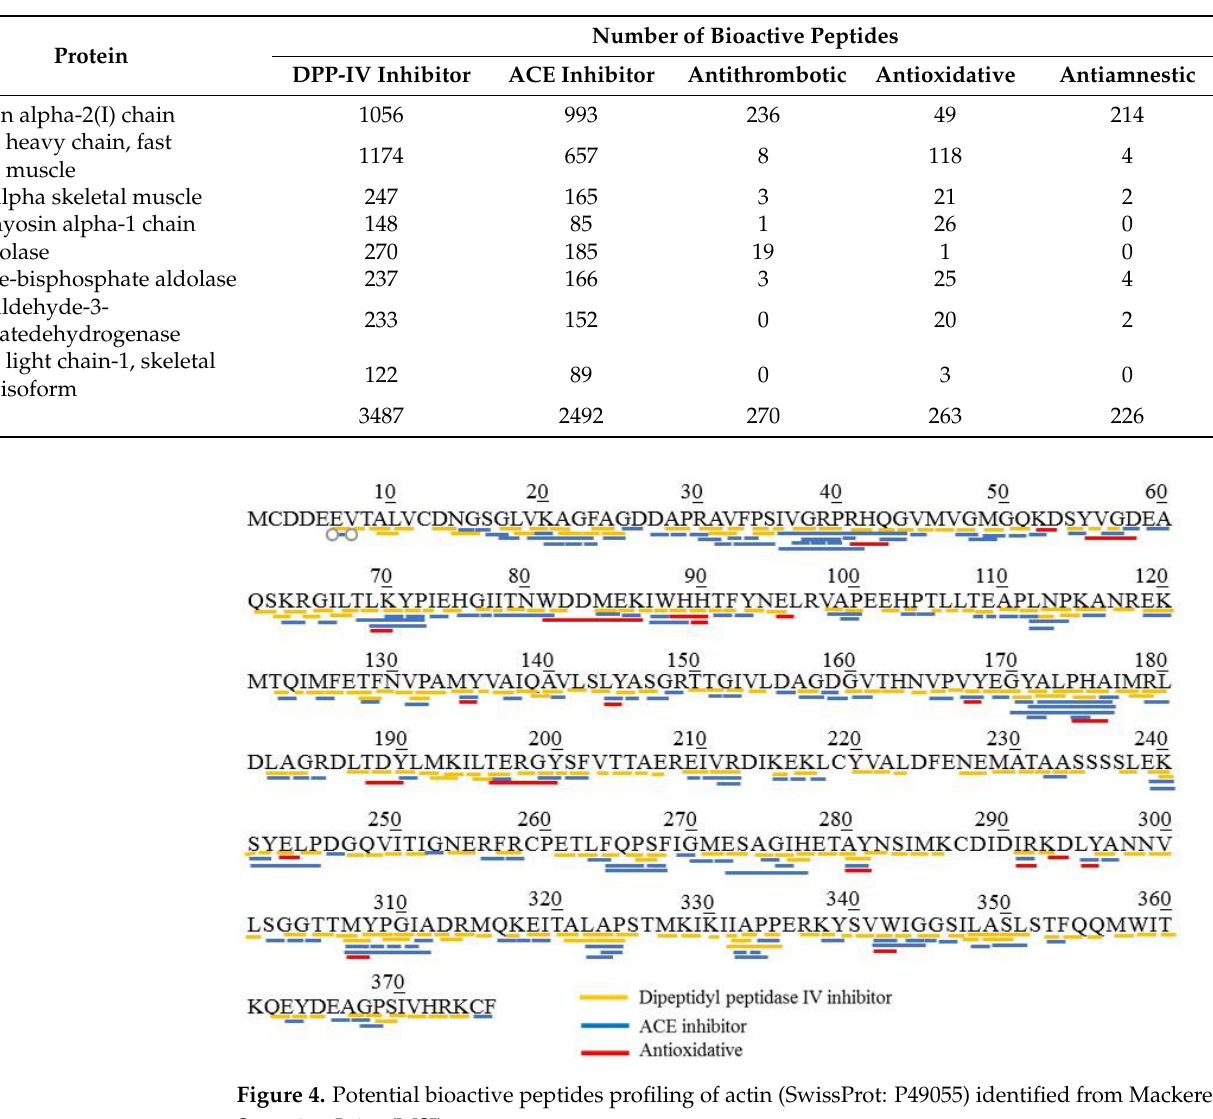
Table 3. Potential bioactive peptides of identified from mackerel steaming juice using BIOPEP’s Profiles of potential biological activity tool.